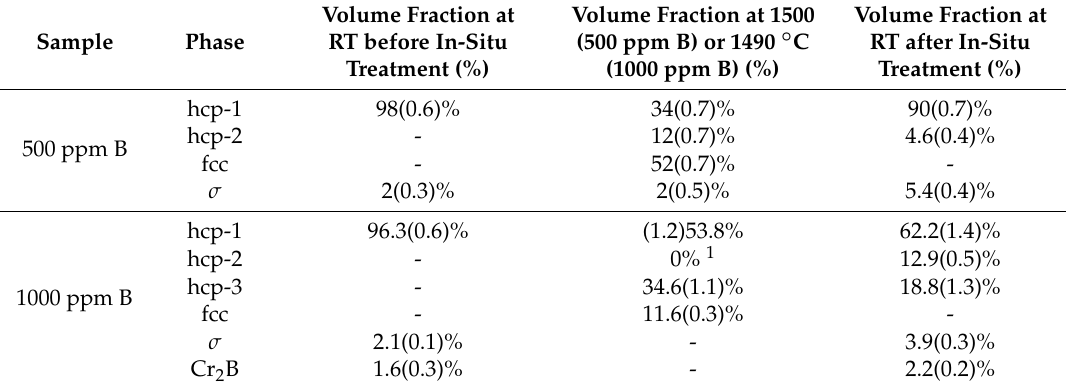
Table 2. Volume fractions of individual phases from the refinement of full ND patterns of 500 ppm B and 1000 ppm B samples. The errors in brackets are standard deviations resulting from the Rietveld